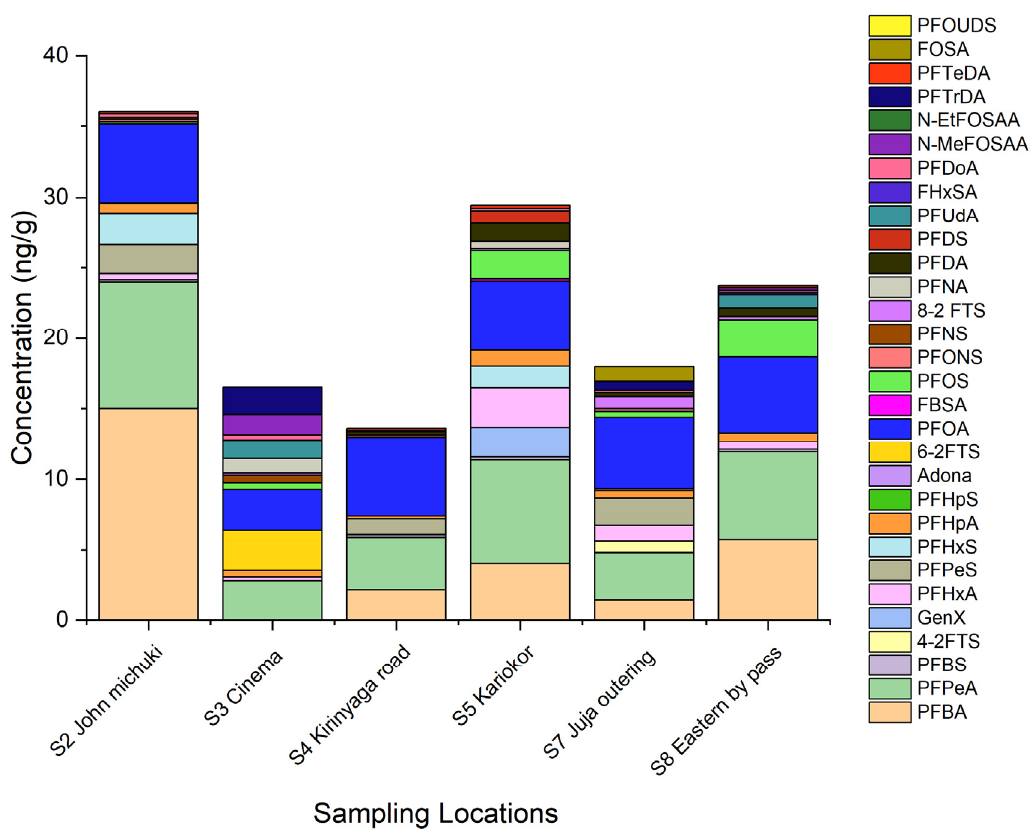
Figure 4. PFAS spatial distribution in plant samples from the Nairobi River Basin.